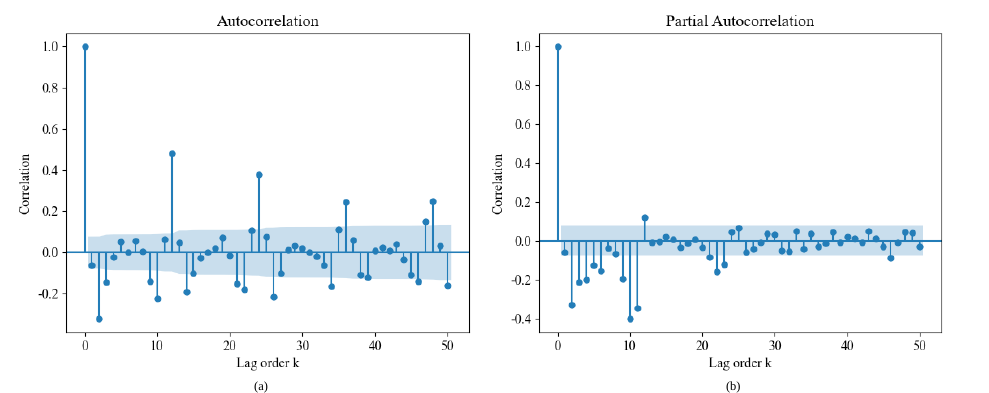
Figure 6. ( a ) The ACF plot of differential time series; ( b ) the PACF plot of differential time series.